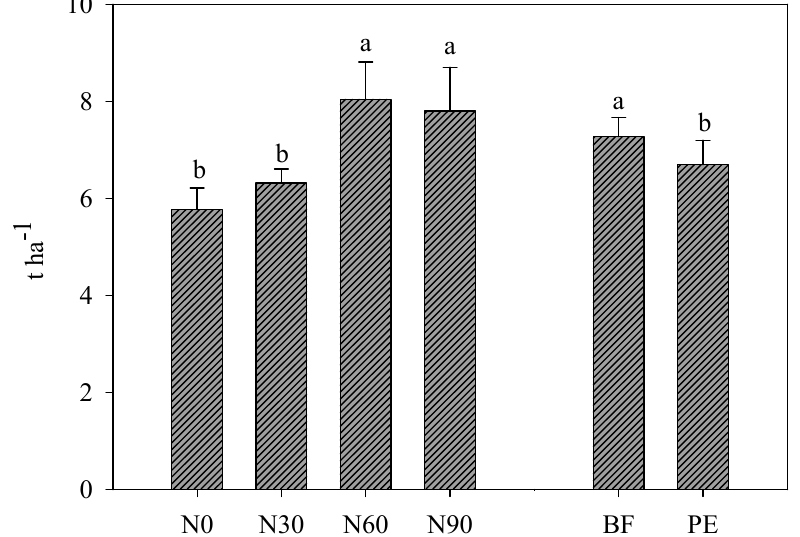
Figure 1. Lettuce yield in relation to mulching cover films (brown photoselective film—BF and black polyethylene—PE) and N fertilization rates (N0 = 0, N30 = 30, N60 = 60, and N90 = 90 kg ha − 1 ). Yield is presented as mean values of three replicates with relative standard errors. Different letters indicate significant differences at p ≤ 0.05. All data are expressed as mean; n = 3.